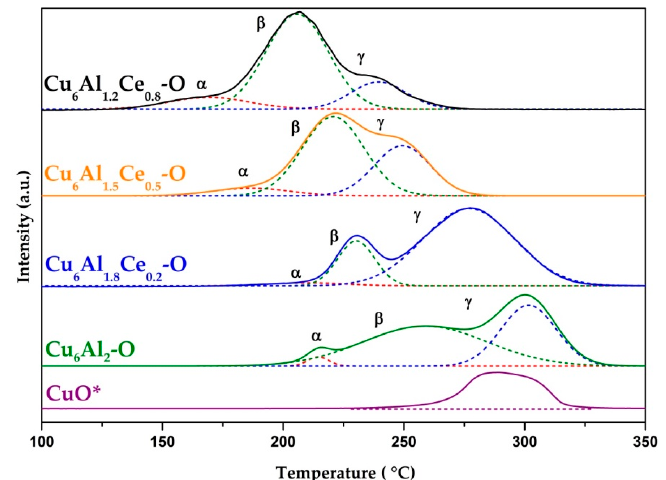
Figure 5. H 2 - temperature programmed reduction (TPR) profiles of CuO and Cu 6 Al 2-x Ce x -O samples. Table 2. Reduction peak temperatures and H 2 consumption for Cu 6 Al 2-x Ce x -O